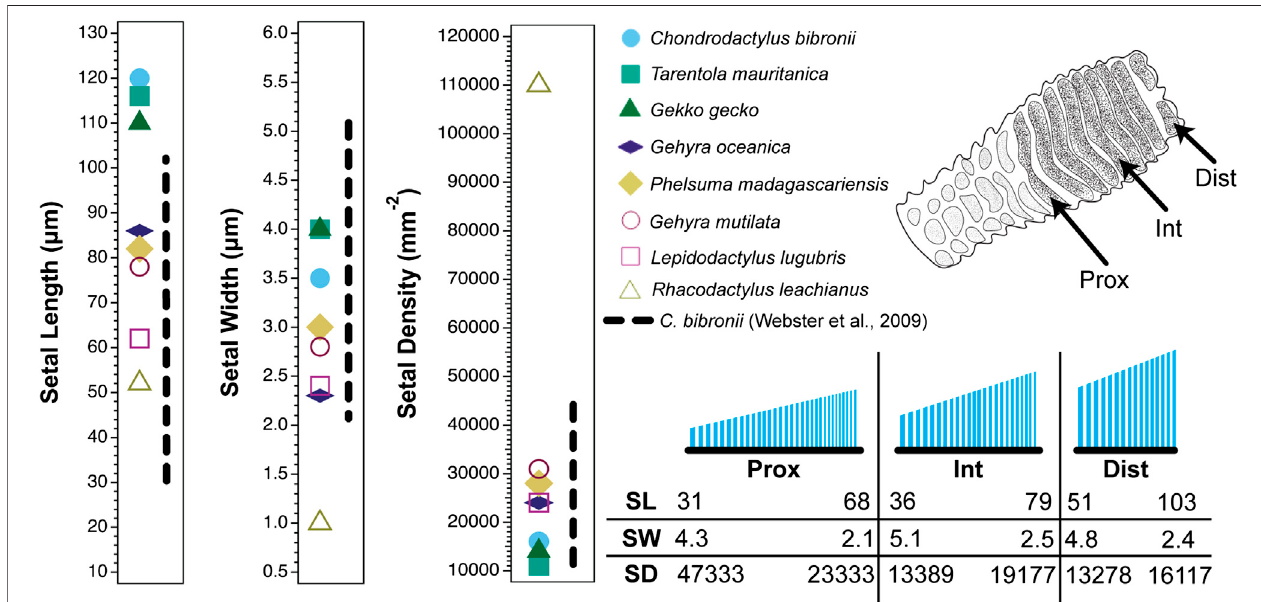
FIGURE1| Setaldimensions(length, width,anddensity)recordedfordigitIV,leftpesofthegekkonidgecko Chondrodactylusbibronii showingvariationinrelation to location on the toe pad. Data are presented for a proximal (prox), intermediate (int) and distal (dist) scansor (see inset of the ventral view of the digit in the upper right corner ofthe fi gure).Thedifferentsymbolsoneachgraphattheleftindicatesingularvaluesreportedforsetallength,widthanddensityforeightgeckospeciesbyPeattie (2007) (see legend). The vertical dashed line to the right of the symbols for each graph represents the range of values expressed by Chondrodactylus bibronii as measuredbyWebsteretal.(2009).Thelowerrightinsetisaschematicofthesetaeontheproximal,intermediateanddistalscansors.Belowthisschematicarevaluesof particularsetallengths(SL;µm),widths(SW;µm)anddensities(SD;mm − 2 )thatcorrespondtoproximalanddistalstationsalongtheproximodistallengthofeachscansor (distal to the